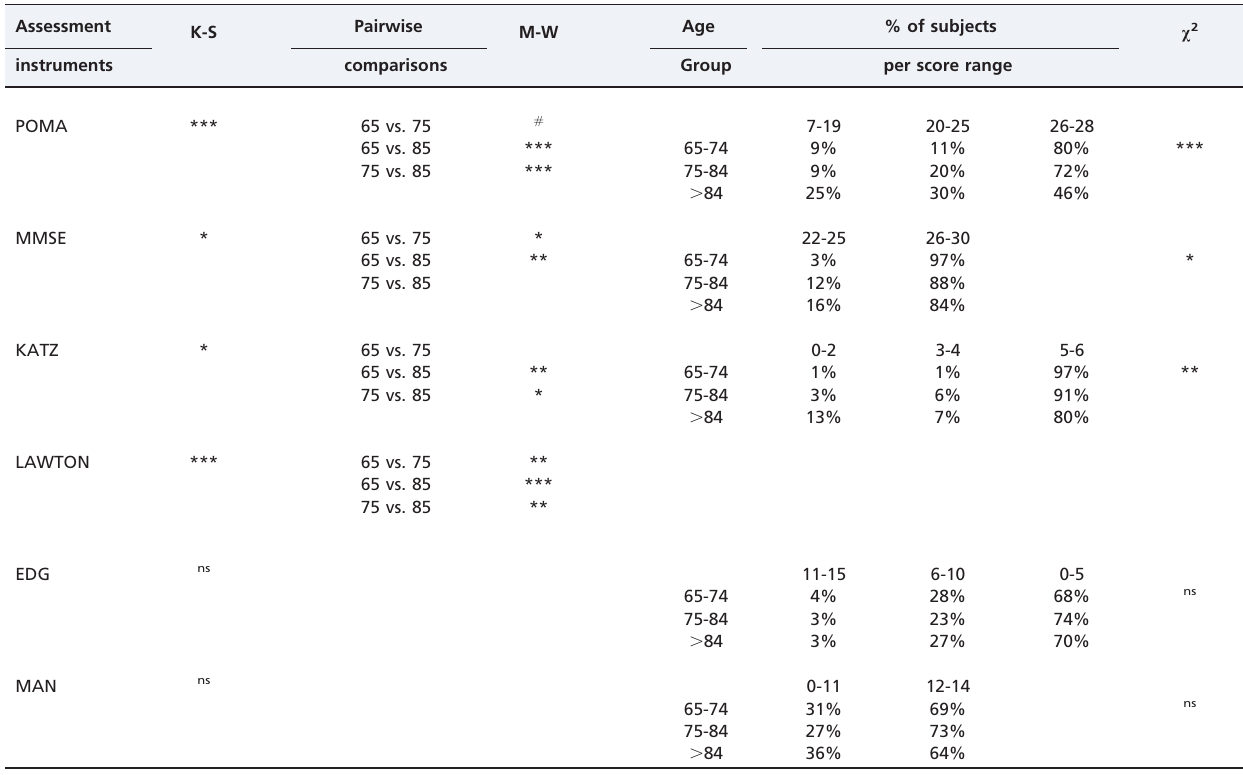
Table 1 - Age effects on functional scores.